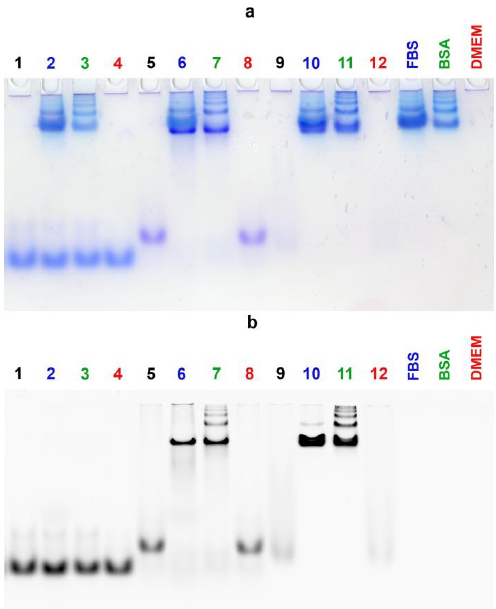
Figure 5. Comparative electrophoretic mobilities of 5 µM control duplex FAM-17′/17 (Lanes 1–4), dodecyl-containing duplex FAM-17′/D-17 PG (Lanes 5–8) and the FAM-D-17 PG conjugate (Lanes 9–12) investigated by EMSA in non-denaturing 8% PAAG after 2 h incubation at 37 °C in DMEM medium (depicted in red), DMEM supplemented with 30 µM BSA (depicted in green), DMEM supplemented with 10% fetal bovine serum (FBS) (depicted in blue). All medium conditions without oligomers control lanes are depicted on the right in corresponding colors. Indicated oligomers after incubation in PBS are depicted in black for additional controls. Bands were visualized after electrophoresis by Stains-All staining ( a ) and by recording the image after scanning with laser excitation at 488 nm ( b ). It is interesting to note that during the electrophoretic analysis of micellar assemblies of